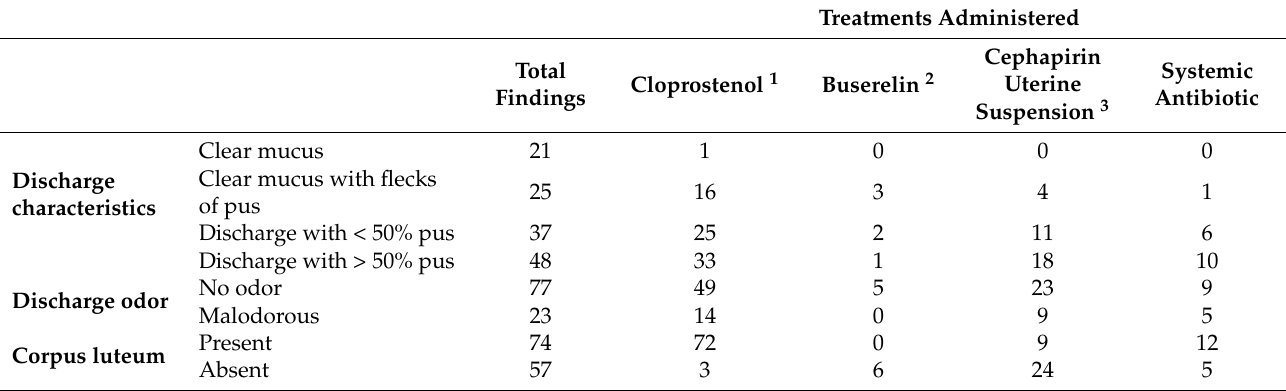
Table 5. Recorded findings and treatments administered during the endometritis prospective clinical audit by veterinarians in Practice 2 over a 4.5-month